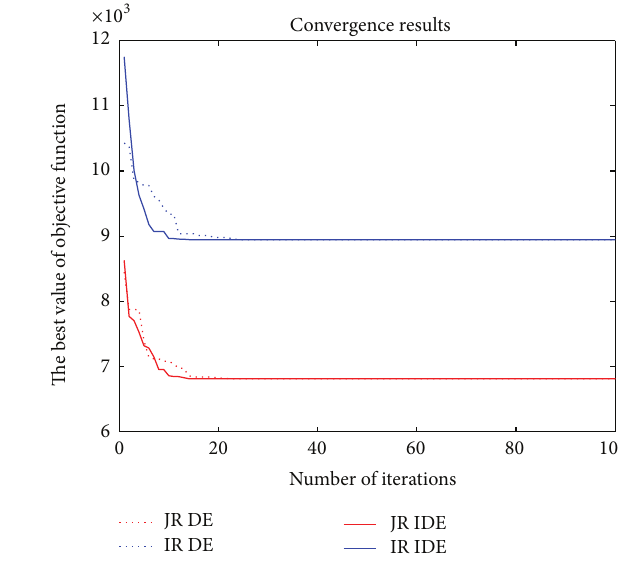
Figure 4: Convergence results of 𝑓 4 . Table 3: CPU time (s) of two different algorithms under four test functions.